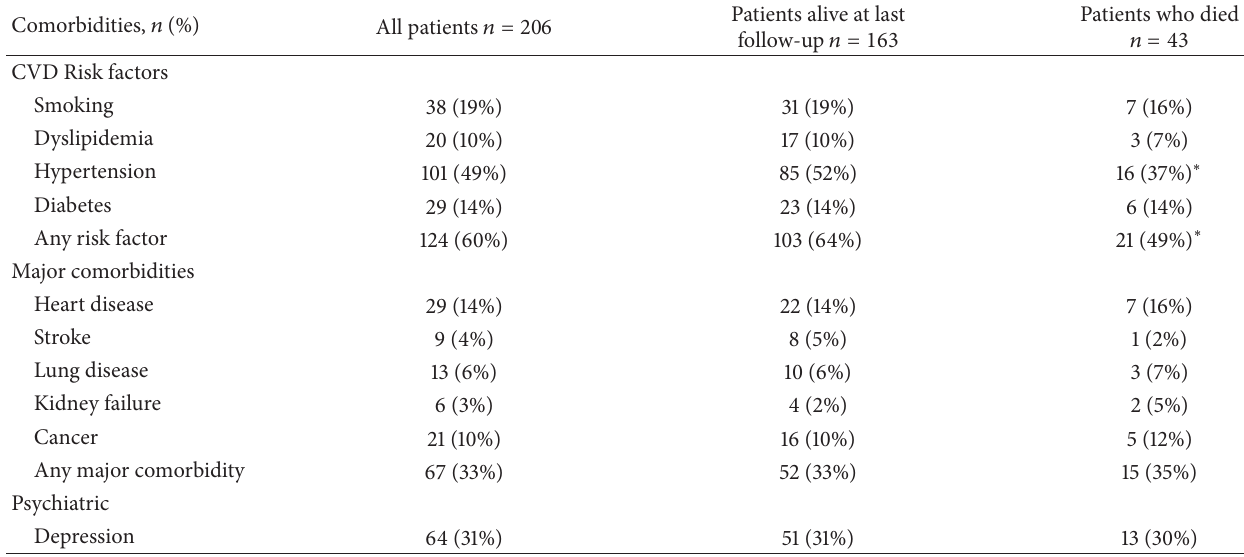
Table 2: Comorbidities and risk factors among PD